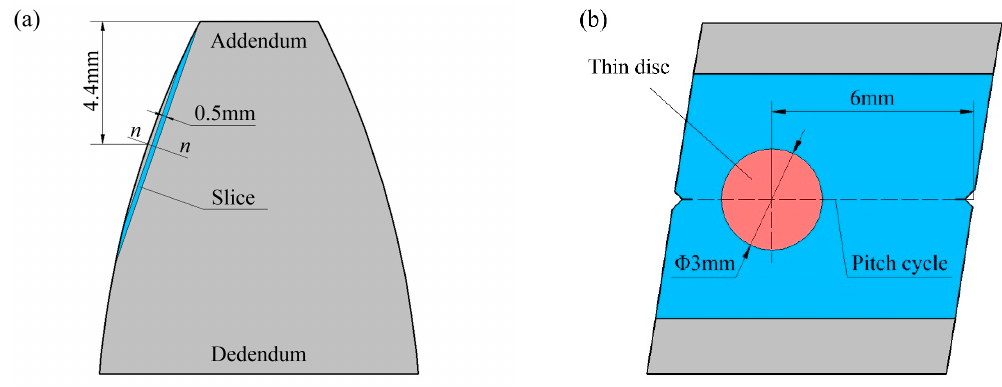
Figure 7. Schematic diagram of the slice: ( a ) the cutting position of the slice labeled in blue, ( b ) the cut slice with the thin disc labeled in red.